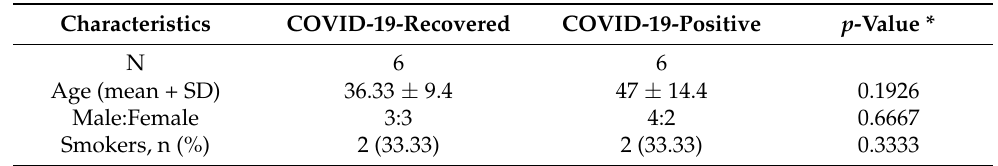
Table 2. Clinical characteristics of COVID-19-positive and COVID-19-recovered patients used in this